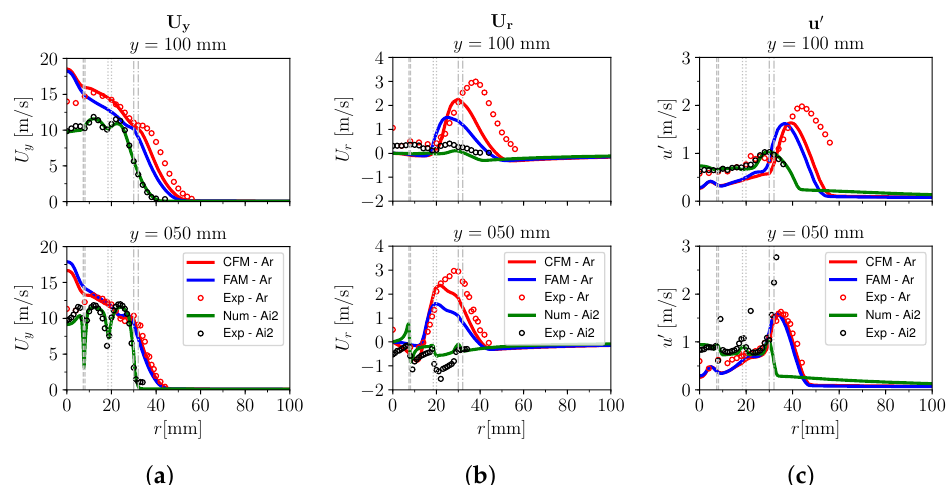
Figure 13. Radial distributions of mean axial velocity U y ( a ); mean radial velocity U r ( b ); and mean turbulence intensity u (cid:48) ( c ); computed at y = 50 and 100 mm from the pilot exit section, in comparison with the experimental data, for both the non-reacting (A-i2) and reacting (A-r) cases of condition A. For case A-i2, the single non-reacting result is included (Figure 6), while for case A-r both CFM and FAM models are considered (Figure